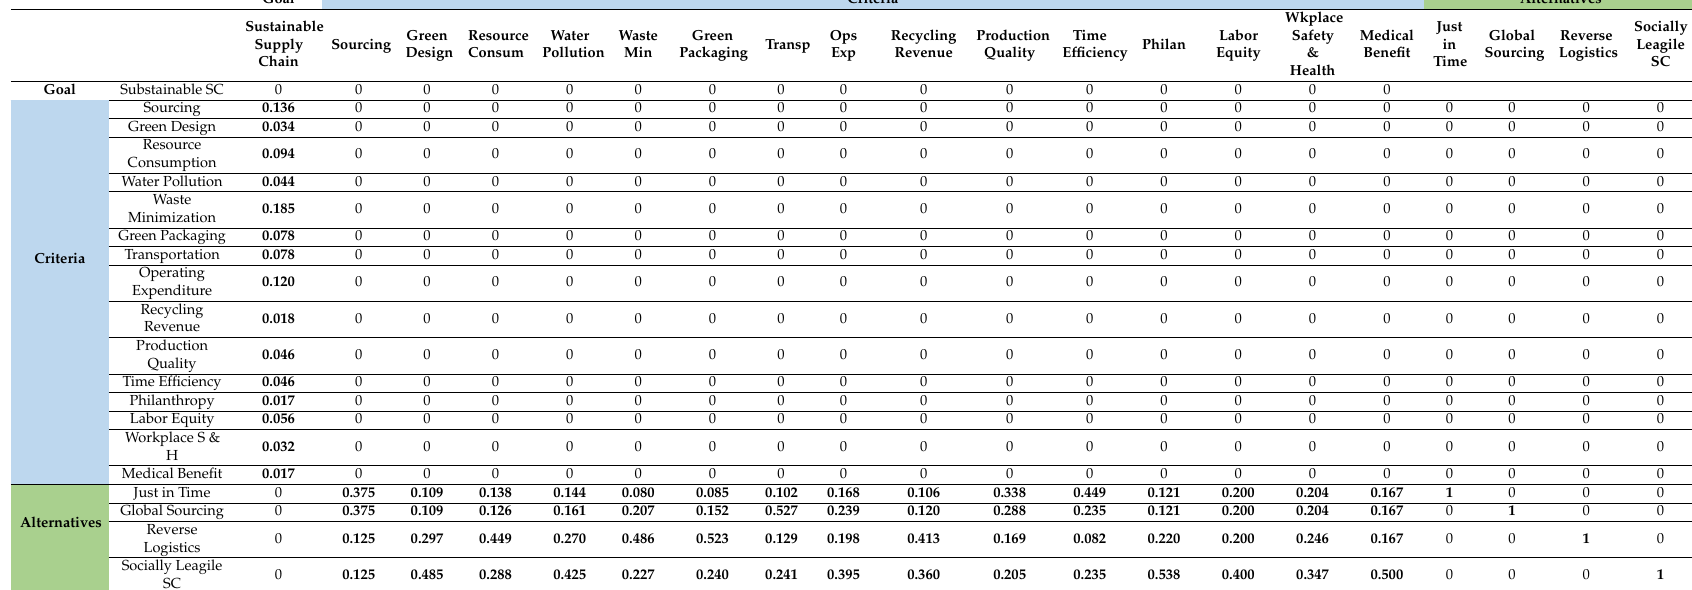
Table 9. Super matrix for the equivalent AHP